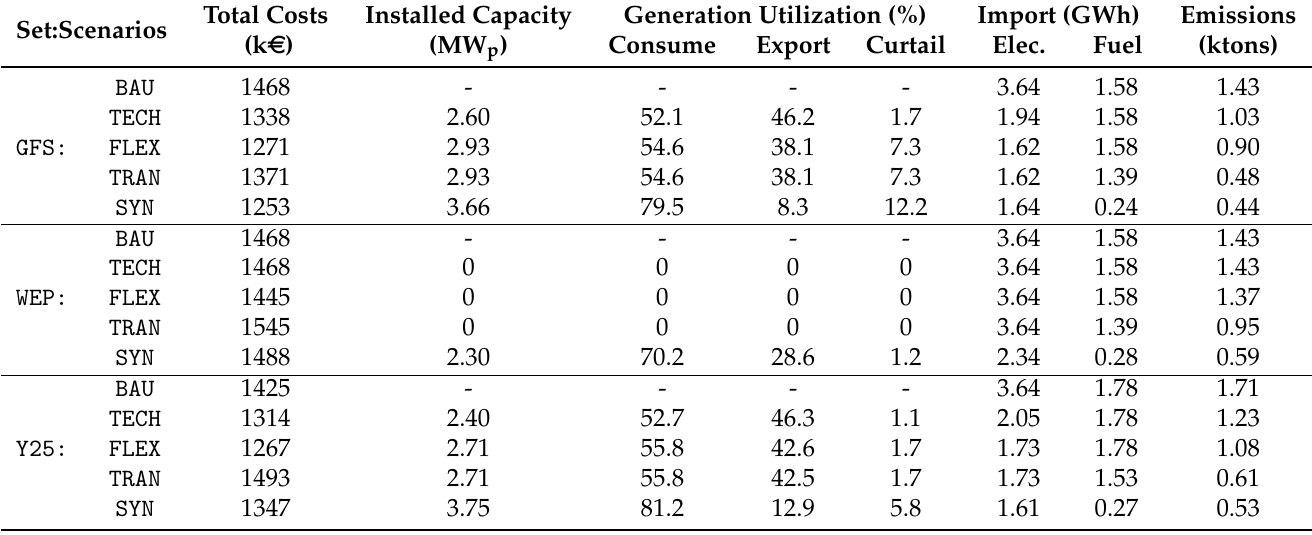
Table A5. Total costs, optimal capacities and generation utilization, energy imports and emissions of the supplementary